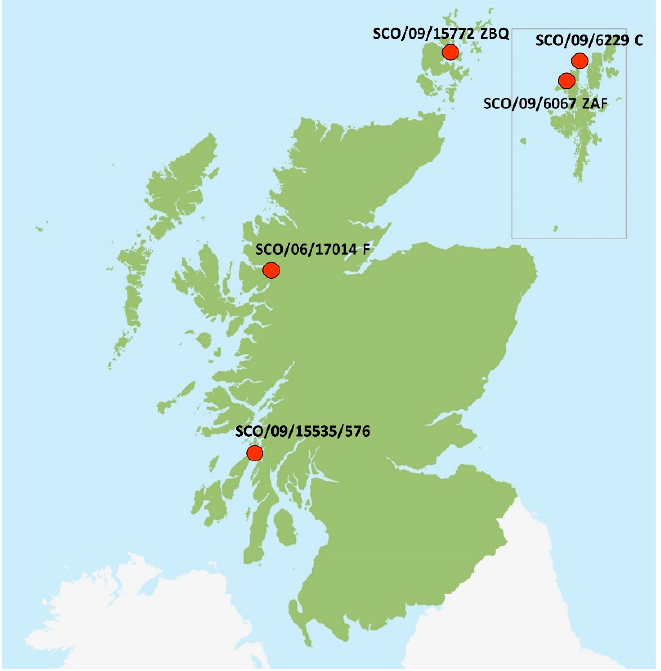
Figure 2. Map showing the geographical location of five of the six Scottish sites included in this study. Information regarding the geographic origin of isolate SCO/09/18948/12225 is not available.